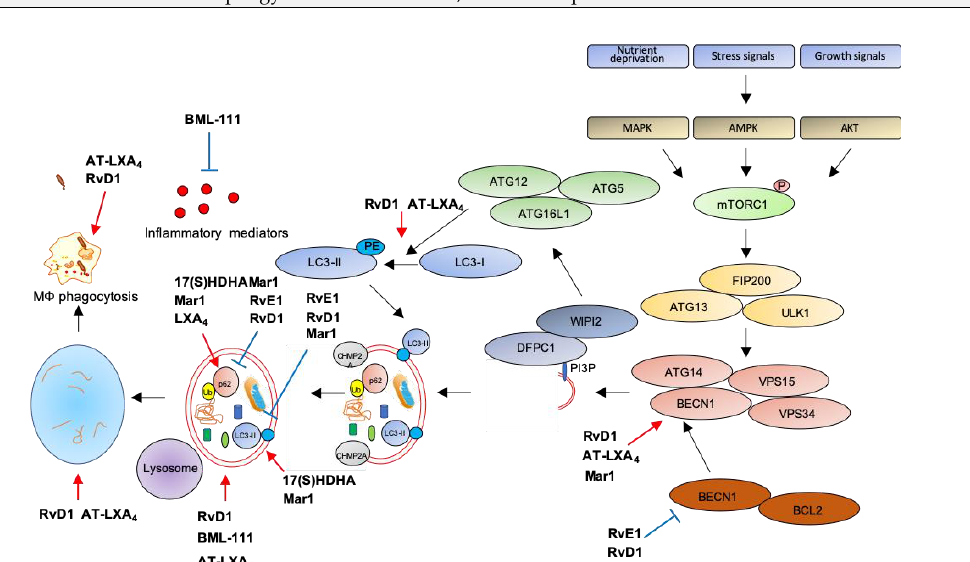
Figure 3. Modulation of autophagy by SPMs. Red arrows: increase; blue bar-headed arrows: decrease in indicated proteins or subcellular compartments. Table 1. Role of SPMs as modulators of autophagy and inflammation in human diseases. SPMs